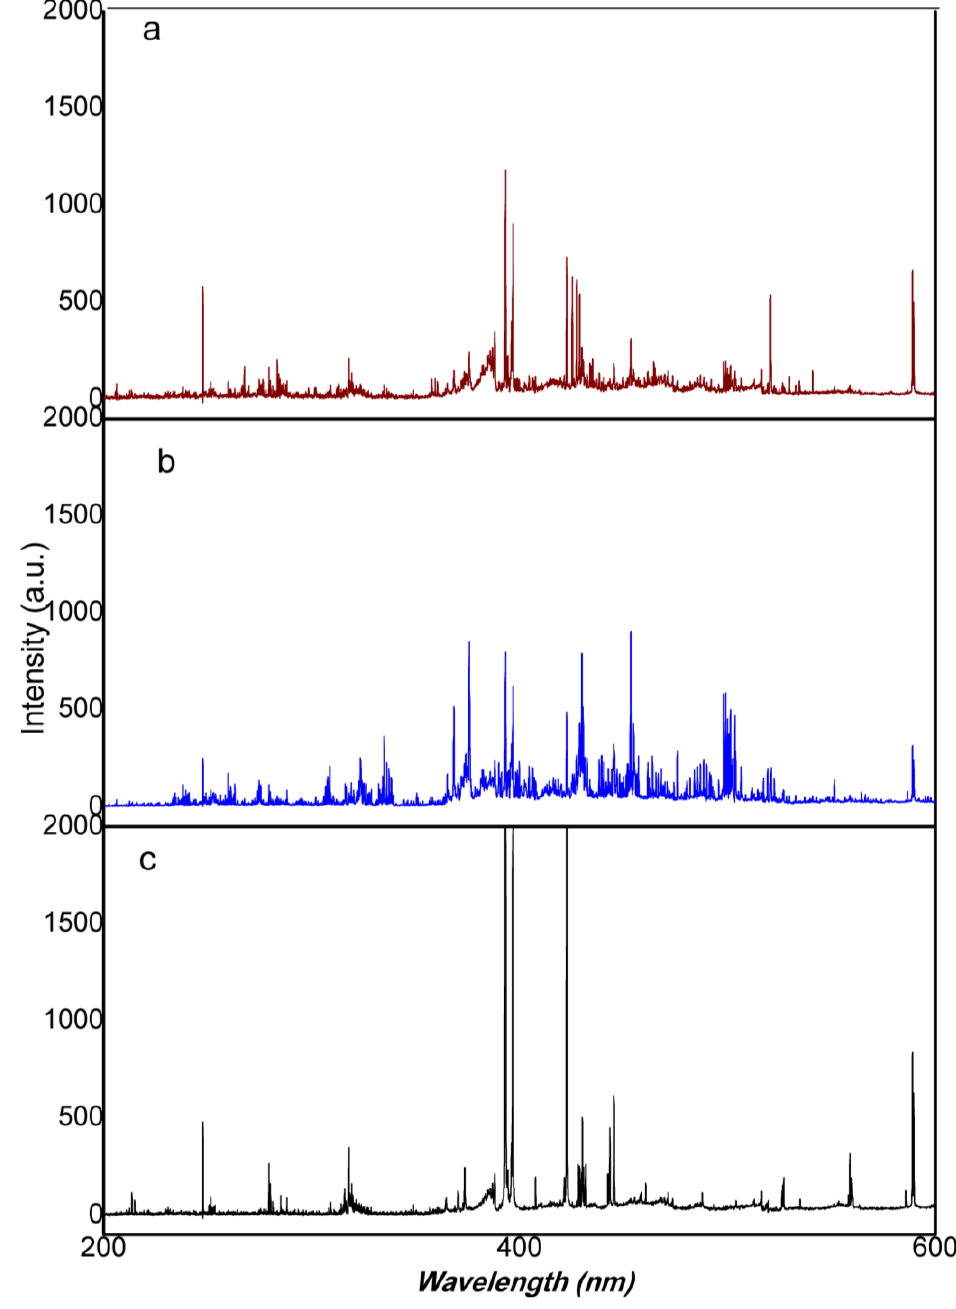
Figure 1. Average spectra of different leather types ( a ) chromium tanning, ( b ) titanium tanning, and ( c ) vegetable tanning.